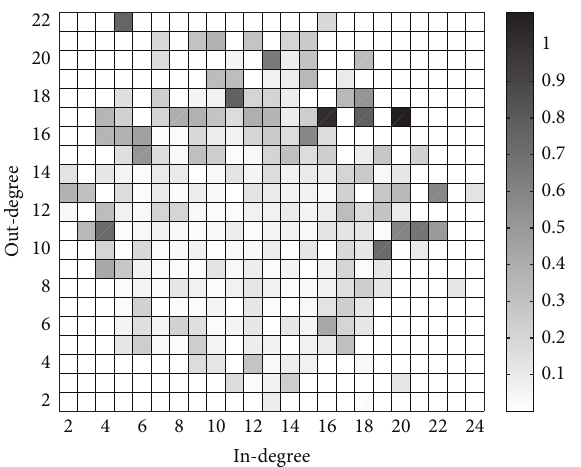
Figure 4: Differences between the results for 𝑢 𝑖,𝑗 from simulations and theoretical analysis.